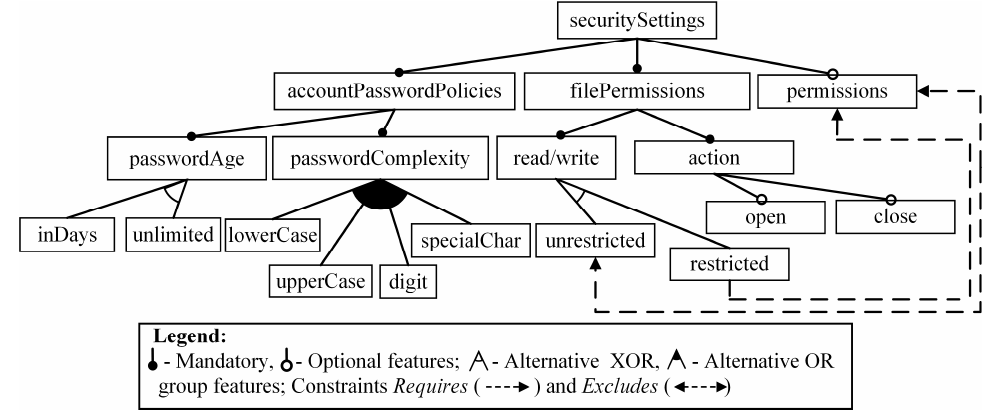
Figure 2. Motivating example to explain feature-based modeling concepts.